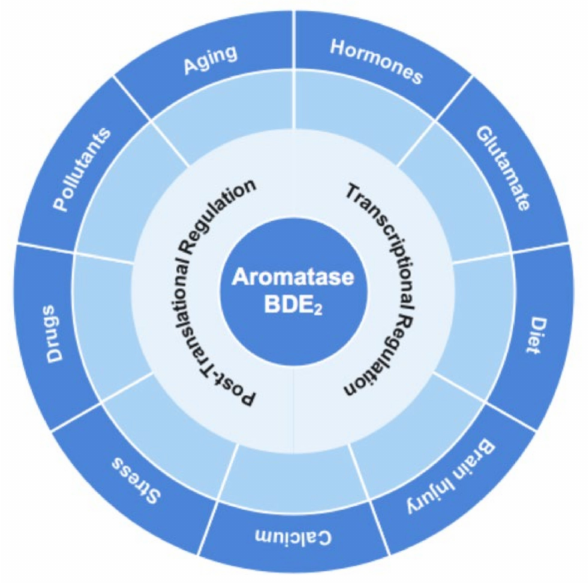
Figure 2. Brain aromatase is regulated by multiple factors. Multiple factors and processes have been implicated to regulate brain aromatase expression and activity. See text for full description and discussion. BDE 2 = brain-derived 17 β